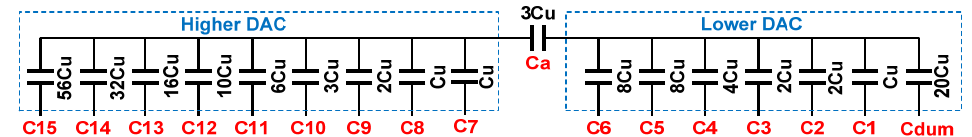
Figure 10. Proposed hybrid redundancy based on the bridge capacitor